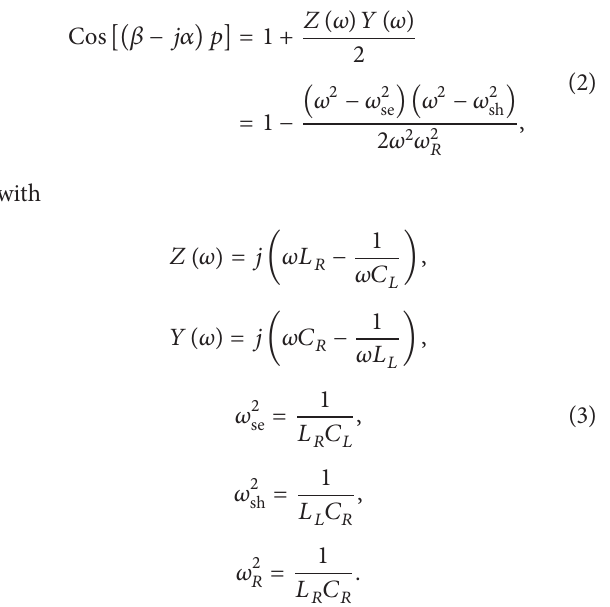
Figure 1: Electromagnetic